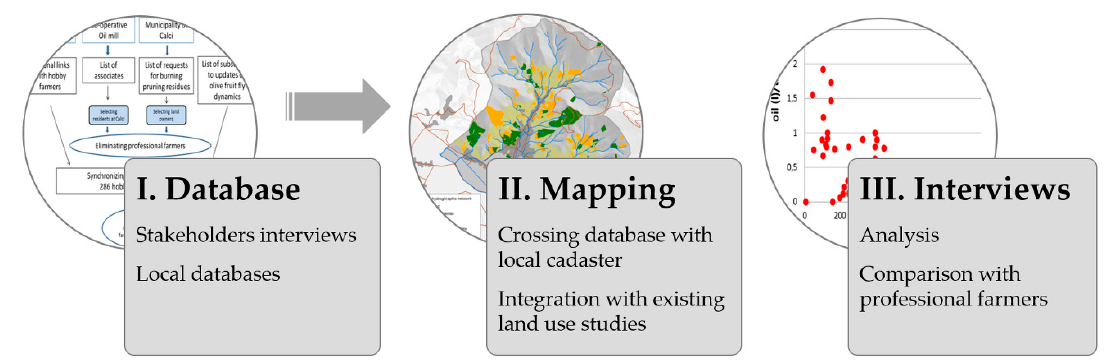
Figure 2. Outline of the method in three steps.